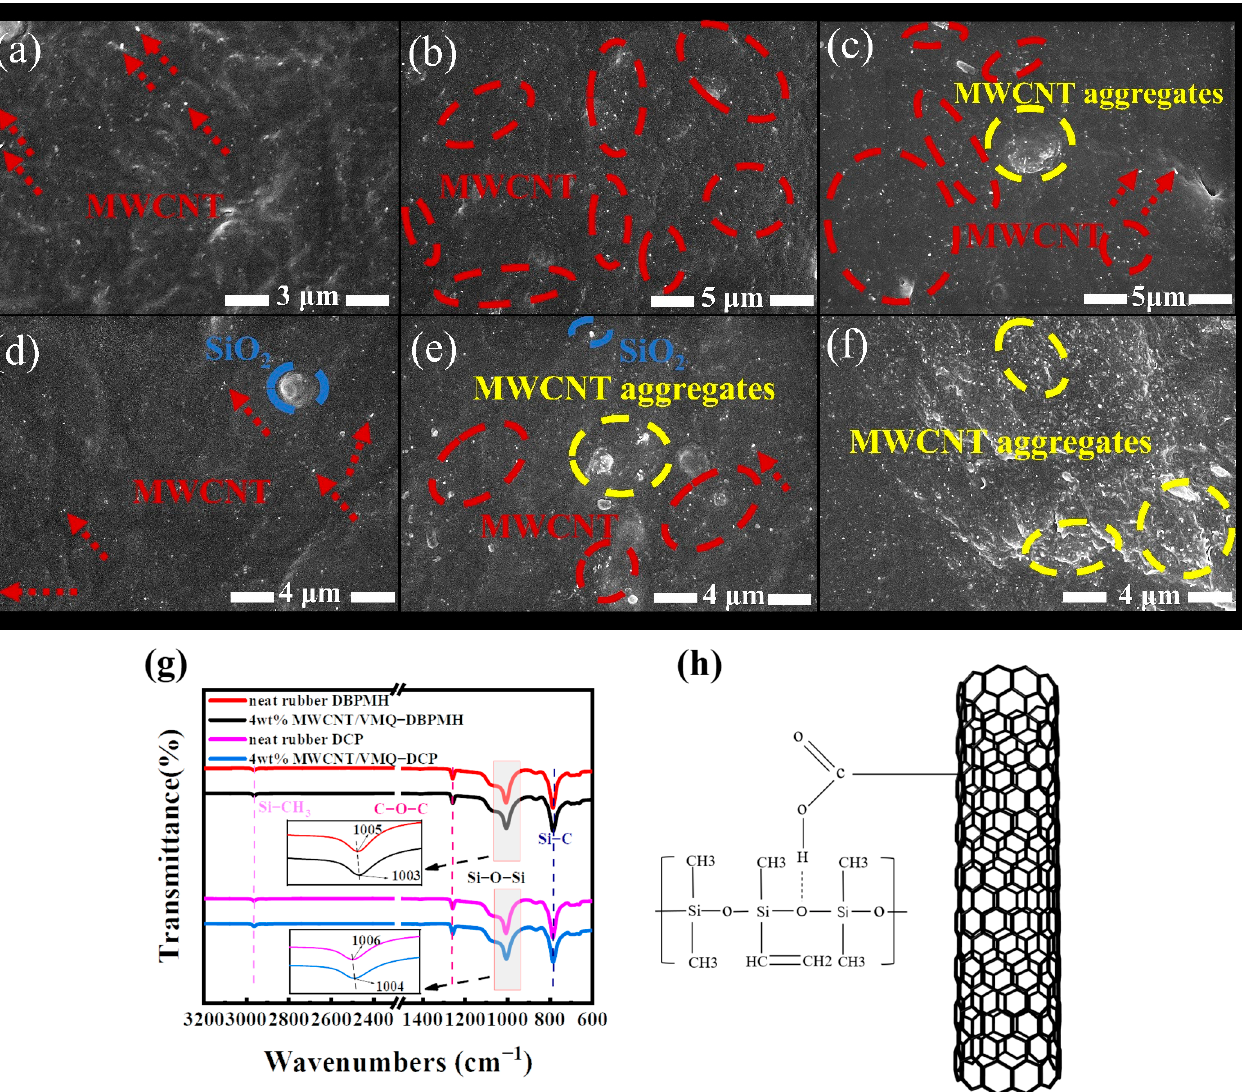
Figure 2. ( a – f ) SEM images of the MWCNT/VMQ-DCP and MWCNT/VMQ-DBPMH composites with different MWCNT mass fractions. MWCNT/VMQ-DCP: ( a ) 2 wt% MWCNT, ( b ) 3 wt% MWCNT. ( c ) Images of 6 wt% MWCNT. MWCNT/VMQ-DBPMH, ( d ) 2 wt% MWCNT. ( e ) Image of 3 wt% MWCNT. ( f ) Image of 6 wt% MWCNT. The dark phase represents the VMQ matrix, red arrow, and bright spot, and the red circle represents the MWCNT cross-section, the blue circle represents the SiO 2 , and the yellow circle represents the MWCNT aggregates. ( g ) FT-IR spectra of the neat VMQ and 4 wt% MWCNT composites with different vulcanizing agents. ( h ) The hydrogen bond that formed between the VMQ matrix and the MWCNT.